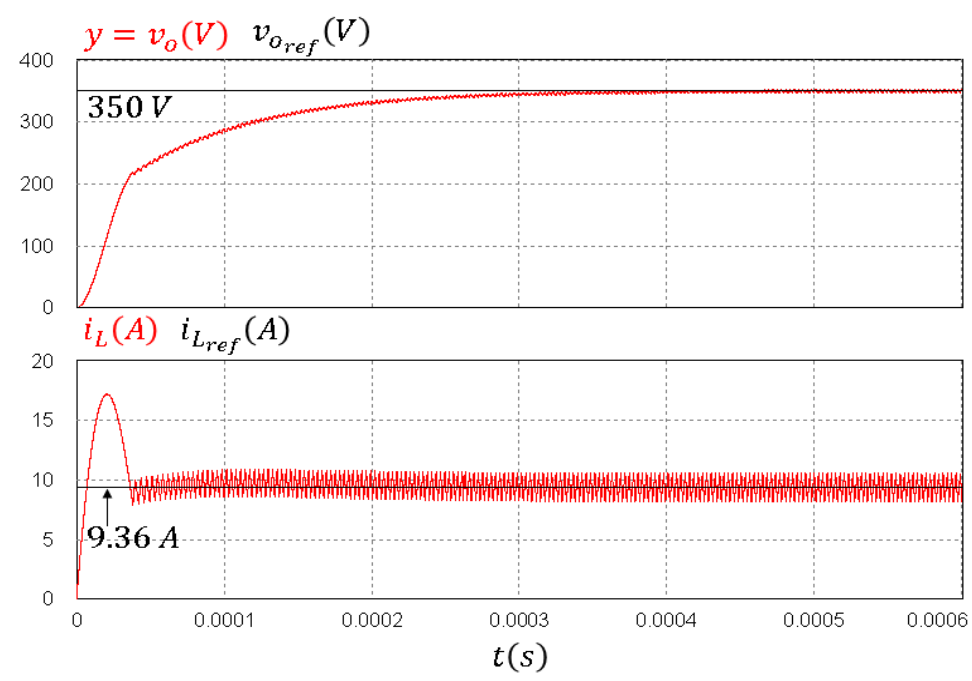
Figure 2. Inductor current and output voltage start-up transient response